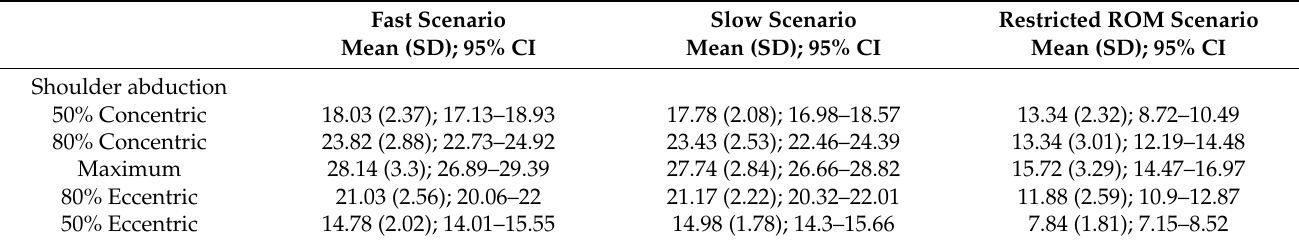
Table 2. Force parameters (Newtons) by scenario for shoulder abduction and knee